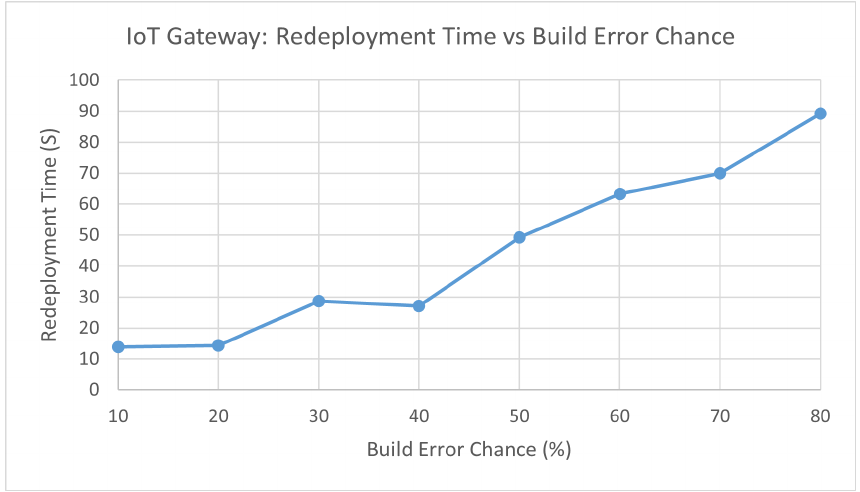
Figure 13. Redeployment Time vs. Build Error